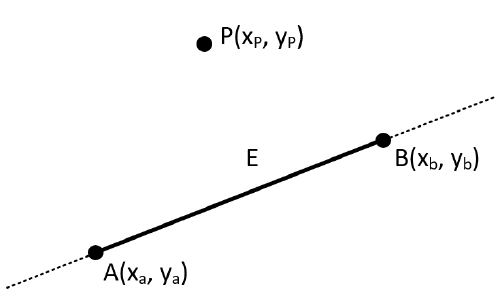
Figure 34. Checking if point P is left, right or on the line segment E .